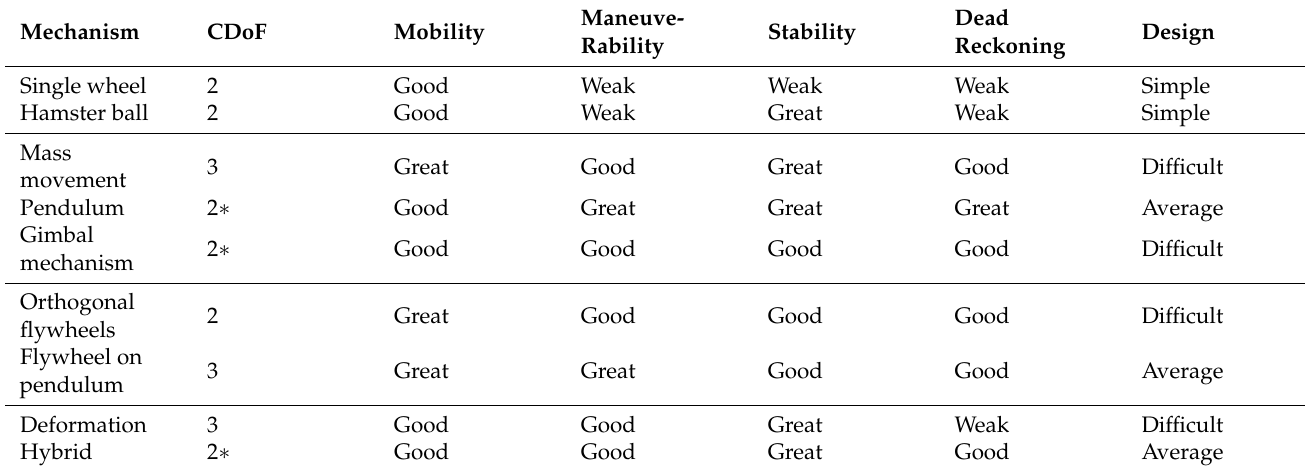
Table 2. Comparison of functional features of SRs driving